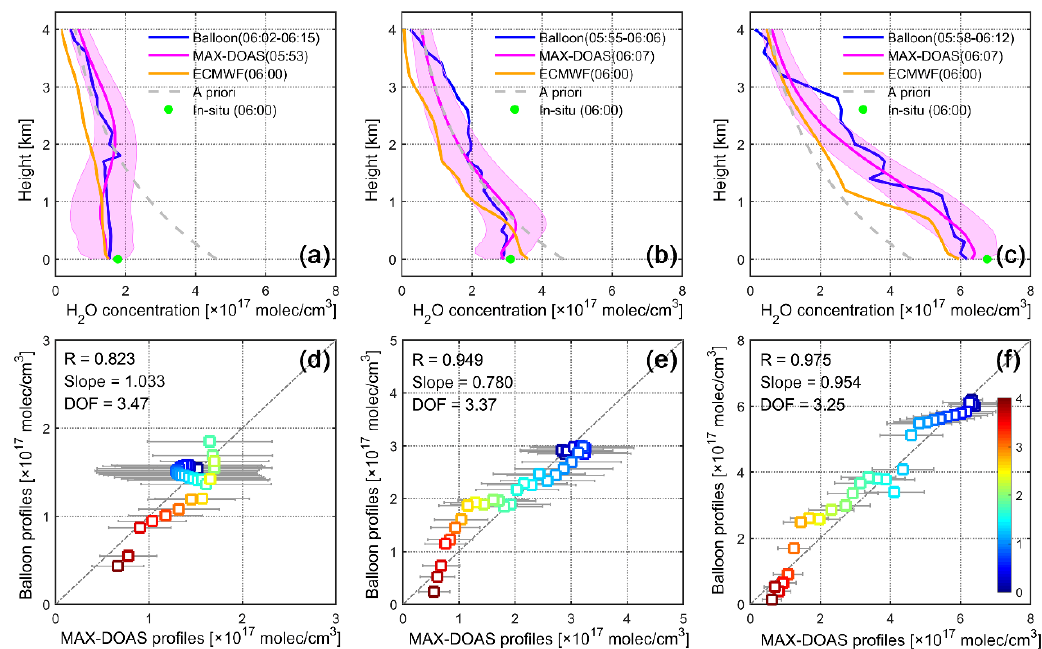
Figure 8. Three typical water vapor profiles retrieved from MAX-DOAS with the corresponding balloon-borne radiosonde measurements, ECMWF ERA-interim datasets, and NCDC in-situ measurements taken on 8 May 2018 ( a ); 19 June 2018 ( b ); and 31 July 2018 ( c ). The blue lines represent the water vapor concentration profiles measured by balloon-borne radiosonde. The pink lines and the shaded areas represent the MAX-DOAS retrieved water vapor profiles and their errors. The orange lines represent the water vapor profiles derived from the ECMWF ERA-interim reanalysis dataset. The dashed gray lines represent the a priori profile used in water vapor profile retrieval. The green dots represent the surface concentration of water vapor measured by the NCDC in-situ instruments. The bottom panels display the corresponding correlation analysis results between the MAX-DOAS-retrieved and radiosonde water vapor profiles on 8 May 2018 ( d ); 19 June 2018 ( e ); and 31 July 2018 ( f ), where colors indicate the height of each layer and the horizontal gray lines indicate the errors of retrieved profile in different height layers.